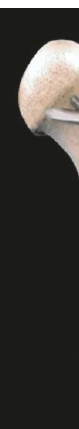
Figure 5: Extramedullary fixation of subtrochanteric femur frac- tures: This diagram illustrates the use of a 95-degree blade plate construct for the treatment of subtrochanteric femur